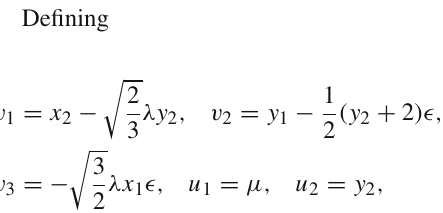
is a saddle point 2